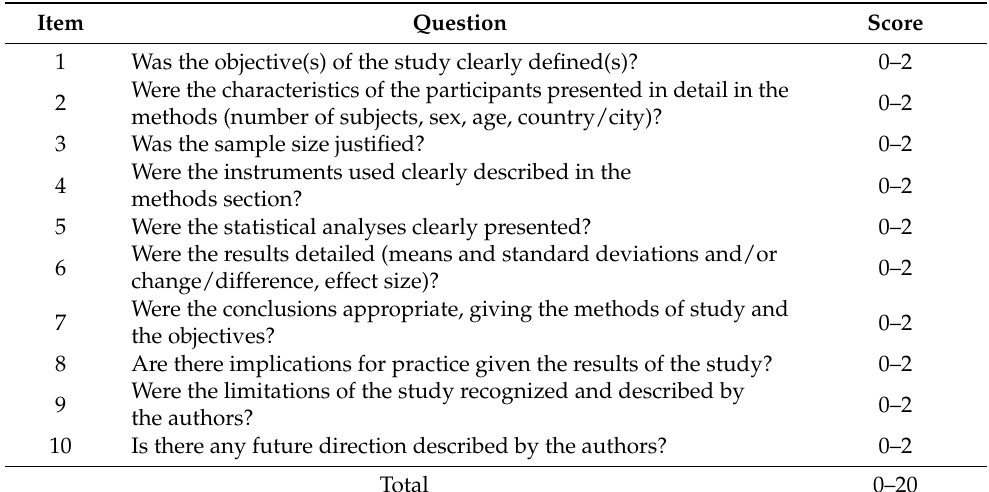
Table 1. Checklist used to evaluate studies’